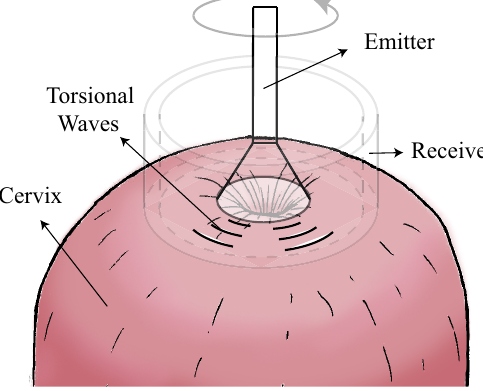
Figure 1. Schematic diagram for the exploration with TW